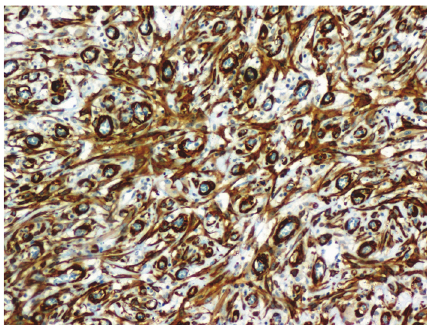
Figure 4: Smooth Muscle Actin immunostaining × 200. Diffuse and intense staining of the spindle cells surrounding the